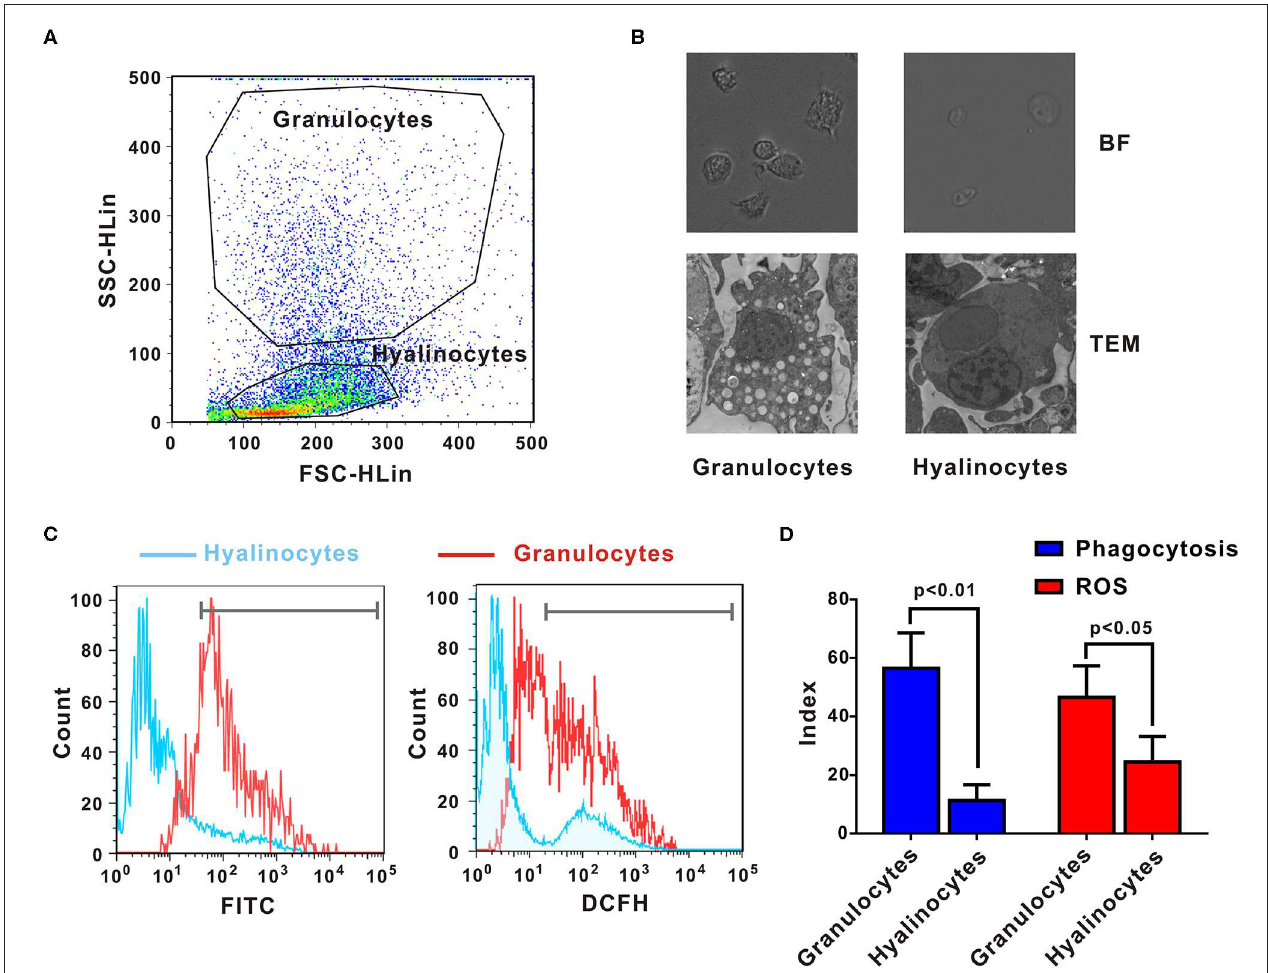
FIGURE 1 | Morphological and functional characterization of C. gigas granulocytes and hyalinocytes. (A) Flow cytometry analysis was conducted to define hemocyte subpopulations. Granulocytes and hyalinocytes were gated, respectively. (B) Granulocytes and hyalinocytes were imaged by light microscopy and TEM. (C) Flow cytometry analysis on the differences between granulocytes and hyalinocytes in terms of phagocytosis ( left panel ) and ROS production ( right panel ). The blue line here represents the functional parameters of hyalinocytes, and the red line represents those of granulocytes. (D) Data analysis was performed by using GraphPad 5 software and vertical bars represent mean ± SEM ( n = 3). Phagocytosis index was represented in the left panel and ROS production was represented in the right